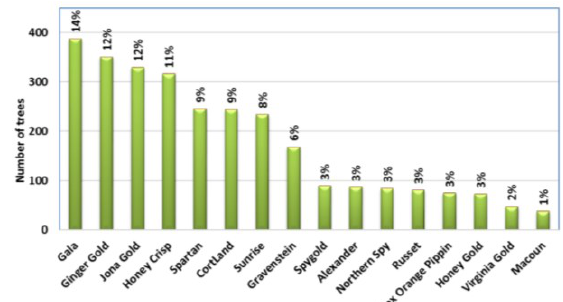
Figure 2. Species frequency for the measured trees in both orchards.